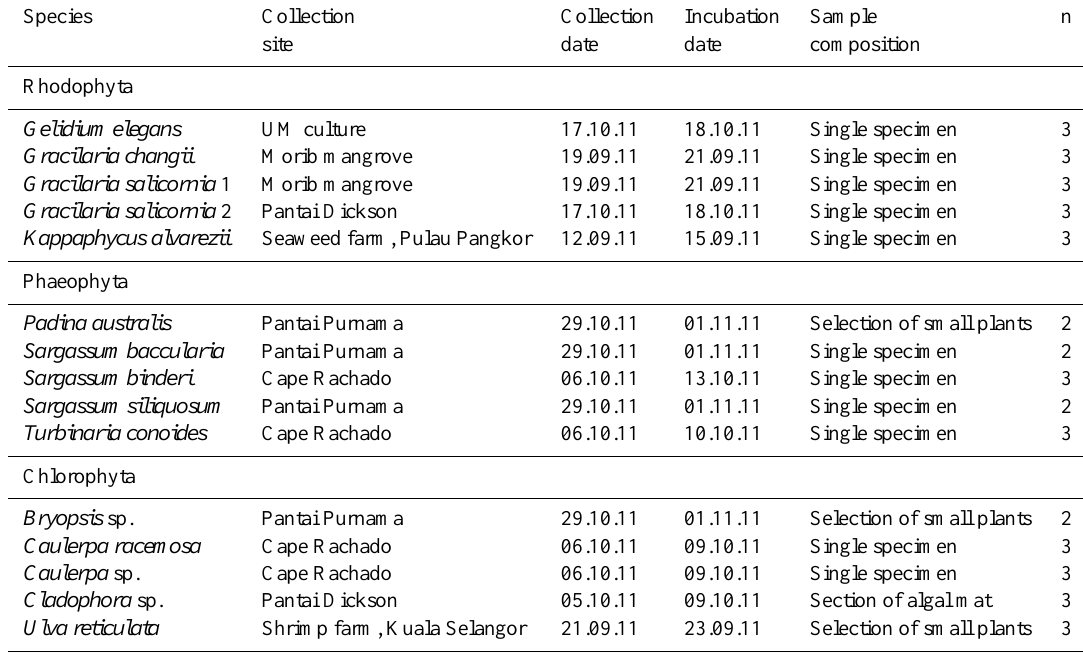
Table 1. Tropical macroalgae investigated, their collection sites and sample details. N =number of replicates used in incubation study.